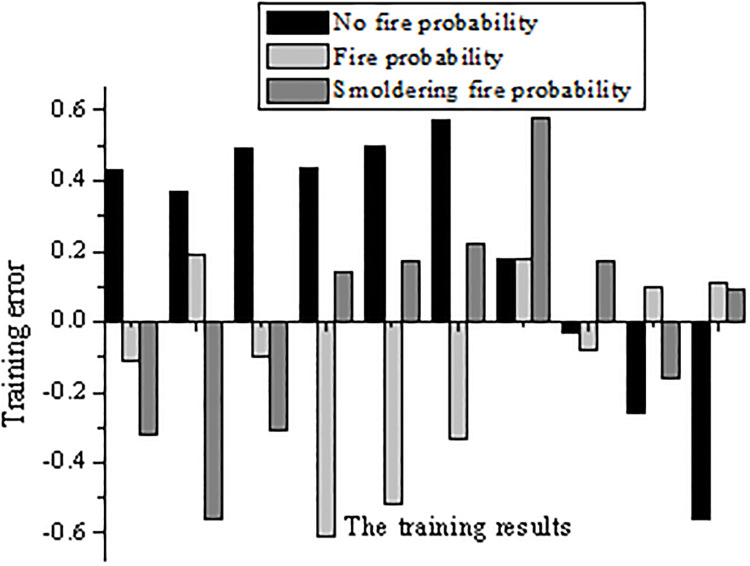
BPNN test results.